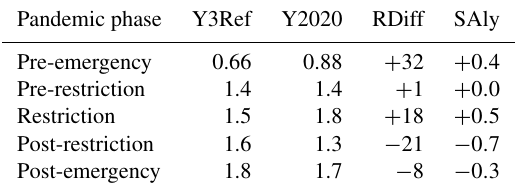
Table 1. Medians of the daily maximum planetary boundary layer height (km) in the average reference year comprising 2017–2019 (Y3Ref) and year 2020 (Y2020) together with their relative differ- ence (RDiff) in % and their anomaly standardised to SD (SAly) over the five consecutive phases of the first COVID-19